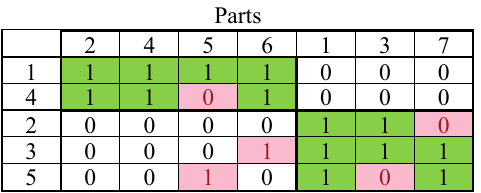
Fig. 7. First optimal 2-cell solution with minimum voids